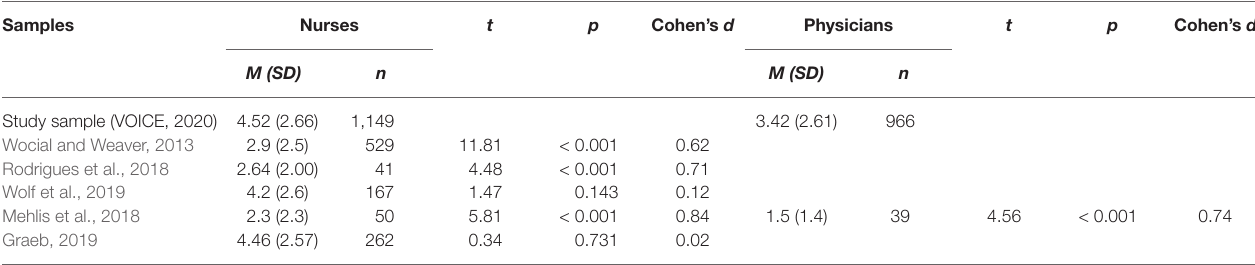
TABLE 2 | Results of independent samples t -tests between moral distress scores in study sample and reference samples.